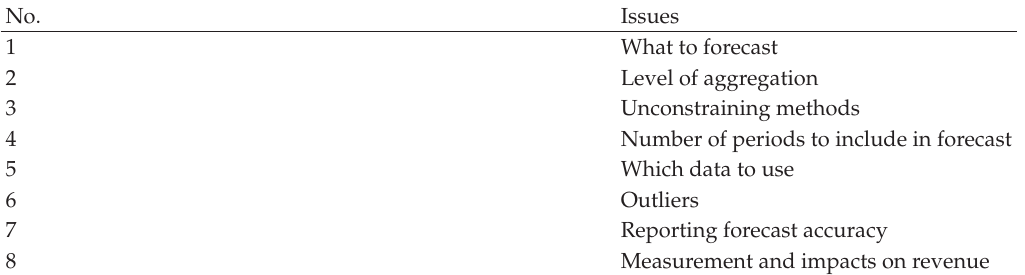
Table 4: Forecasting issues in